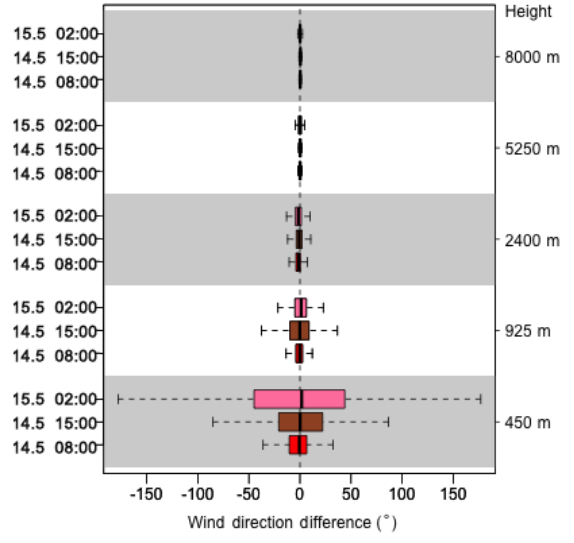
Figure 19. Wind direction differences between HR and HR_RESHIFT in domain